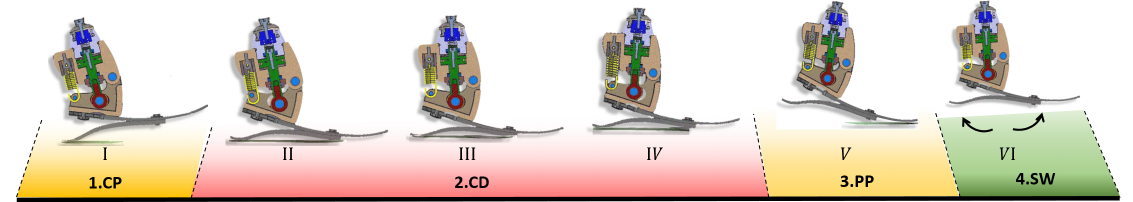
Figure 4. Working principle of the H2AP during the gait cycle.